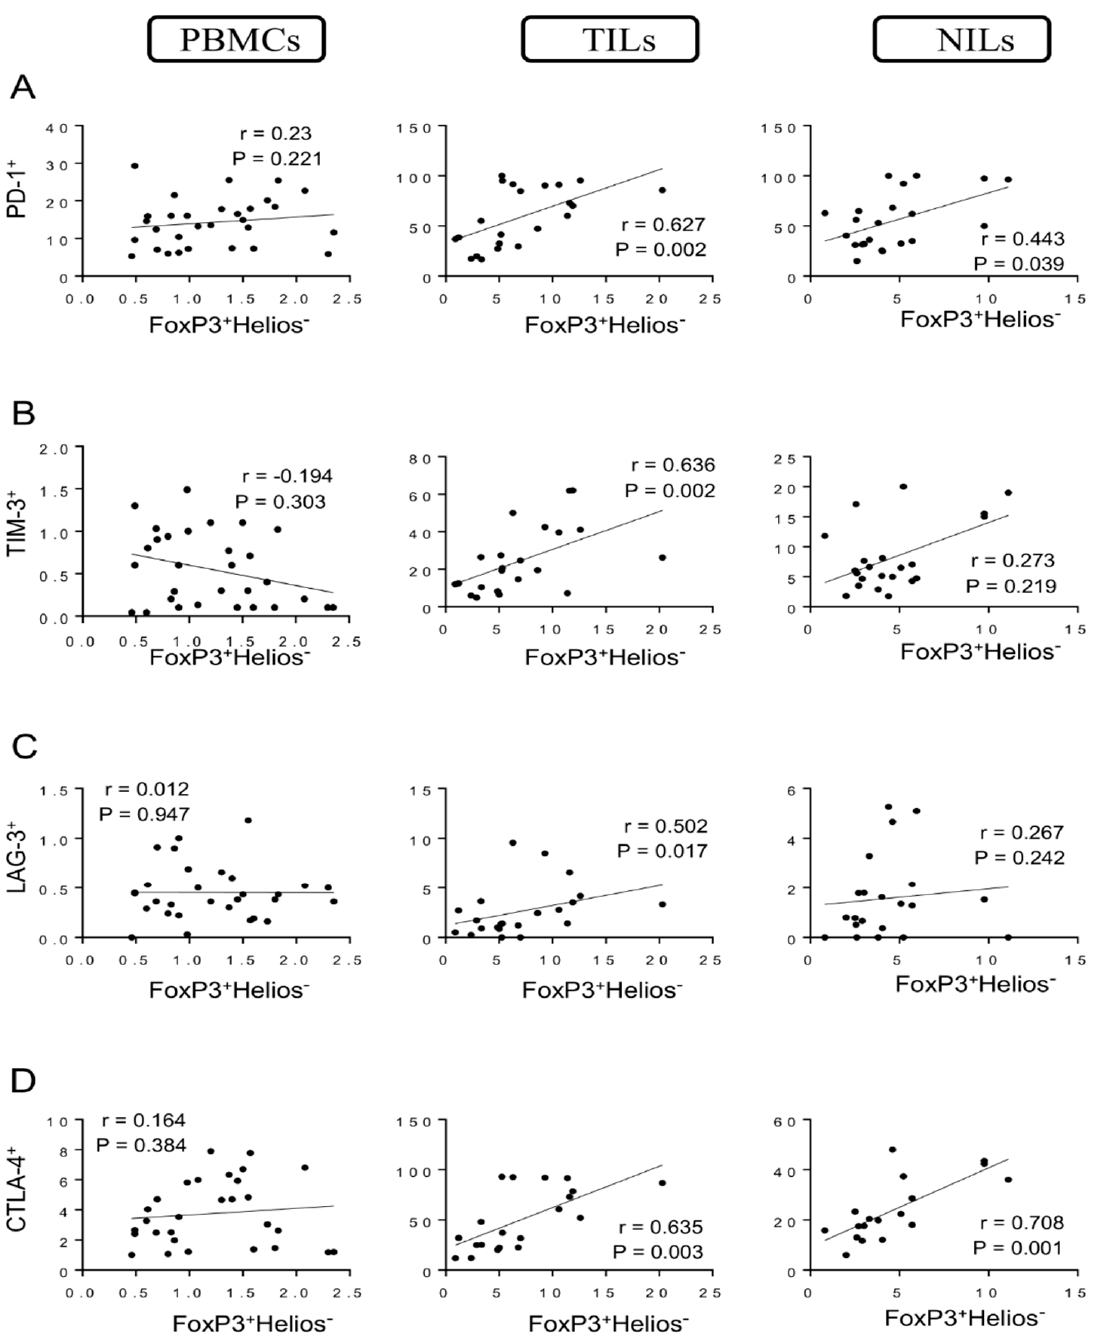
Figure 4. Correlations between levels of FoxP3 + Helios − and immune checkpoints in CD4 + T cells in CRC patients. Correlations between levels of CD4 + FoxP3 + Helios − Tregs with PD-1 + ( A ), TIM-3 + ( B ), LAG-3 + ( C ), and CTLA-4 + ( D ) in PBMCs, TILs, and NILs.